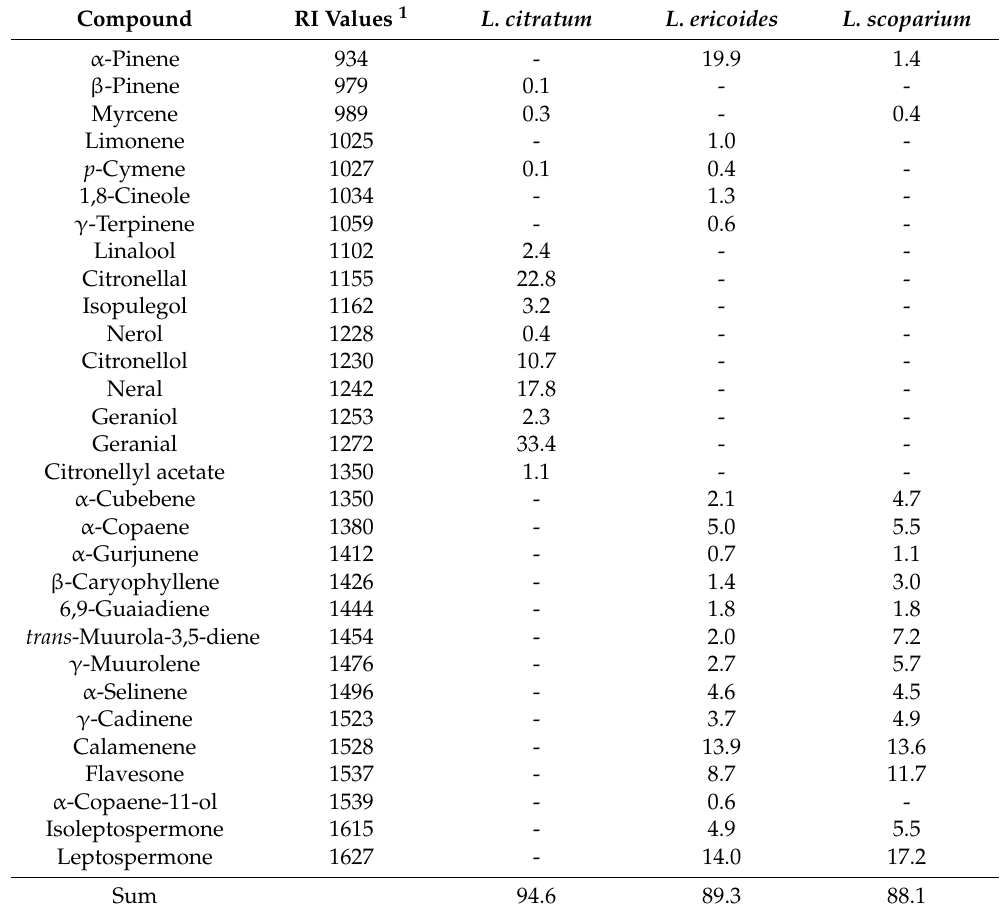
Table 1. GC-MS identification, RI values and % peak area contribution of active oil components.